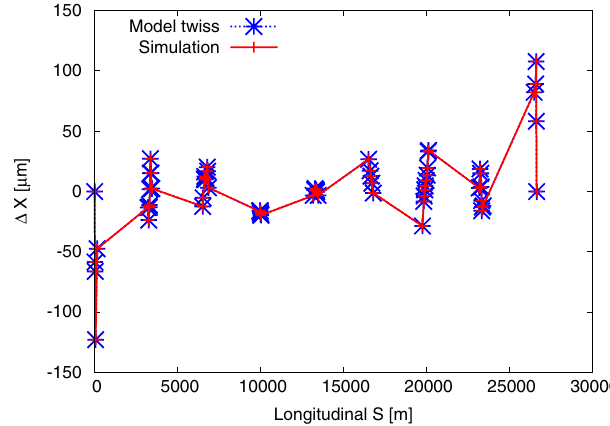
FIG. 4. (Color) Comparison of crab dispersive orbit between theoretical results (blue) and LHC simulation (red).